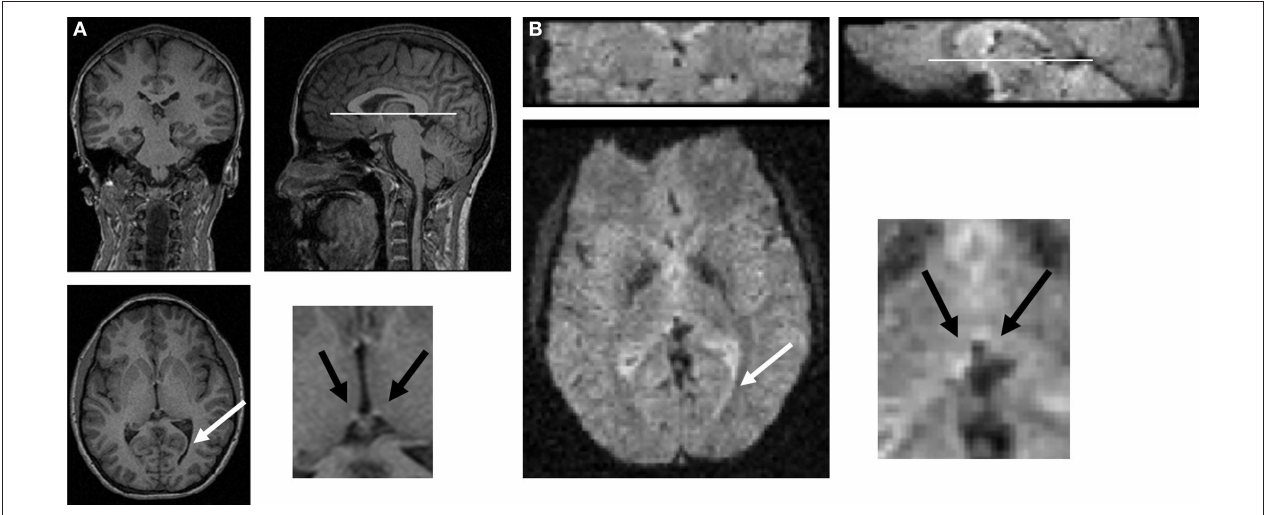
FIguRe  | Manual co-registration procedure. (A) For each subject, the habenula was manually located in structural images (black arrows, inset) using a series of landmarks (in this case, bottom of corpus callosum – white line, and a turn in the right ventricle – white arrow). Landmarks were chosen in